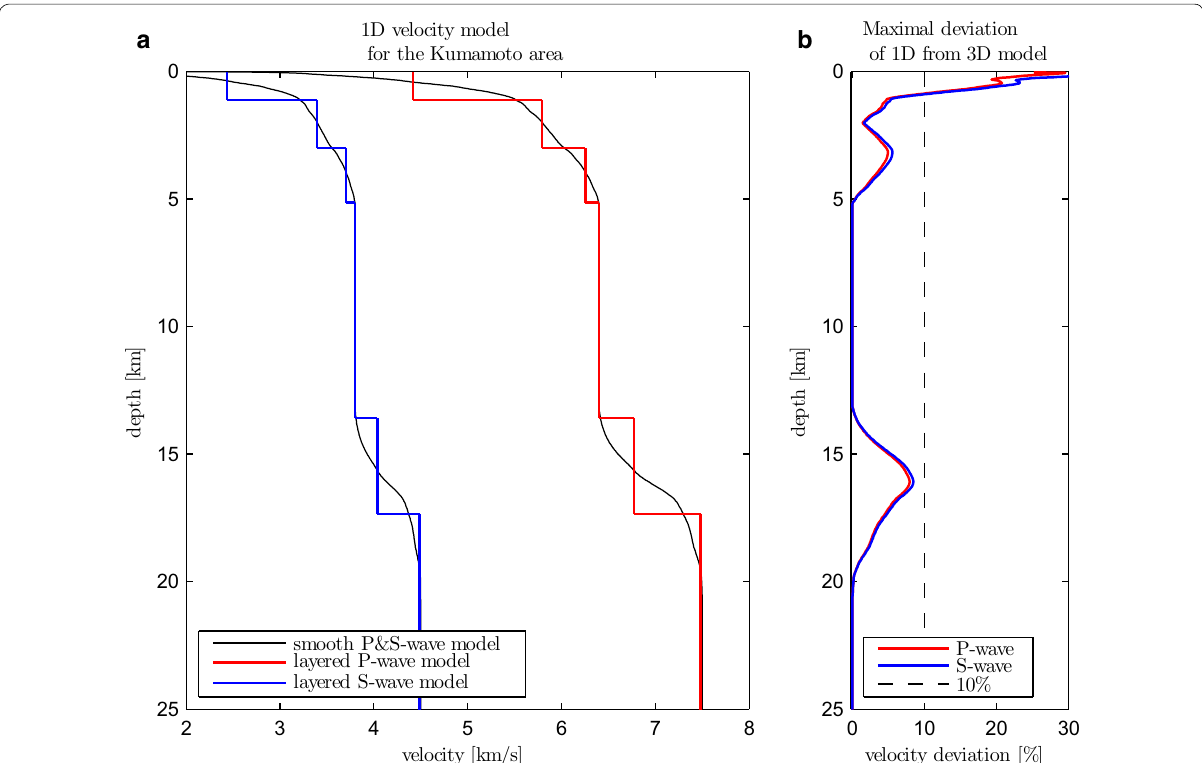
Fig. 2 a 1D velocity model of the Kumamoto area determined from the 3D Japan Integrated Velocity Structure Model (Koketsu et al. 2012) and b maximal horizontal deviation of the velocities of the determined 1D model from the original 3D